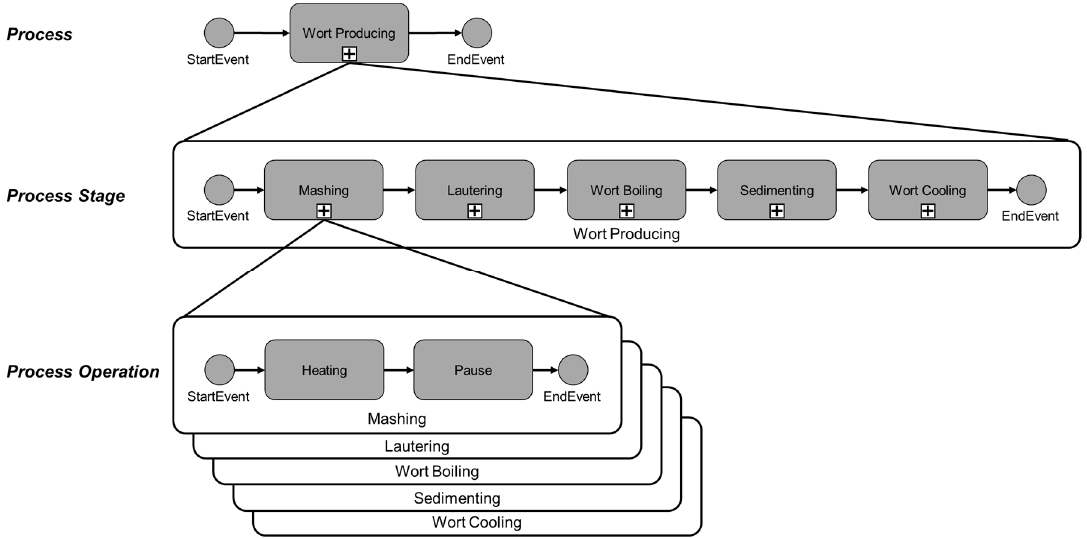
Figure 11. Process model of the brewing process.